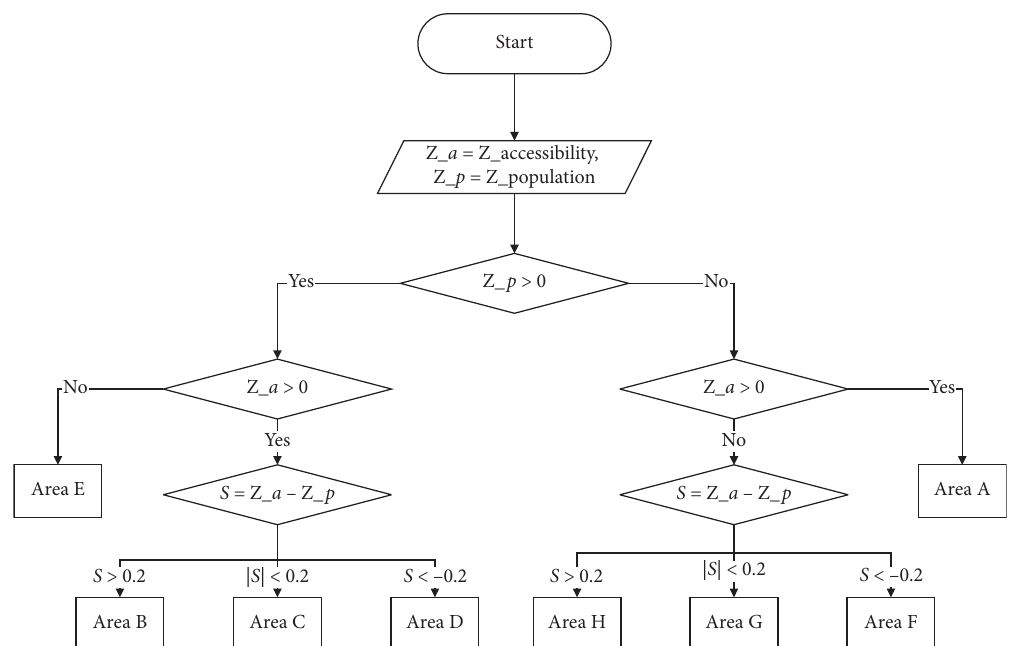
Figure 1: Measurement of accessibility-population balance. The study area is assessed according to normalized measurements of ac- cessibility and population